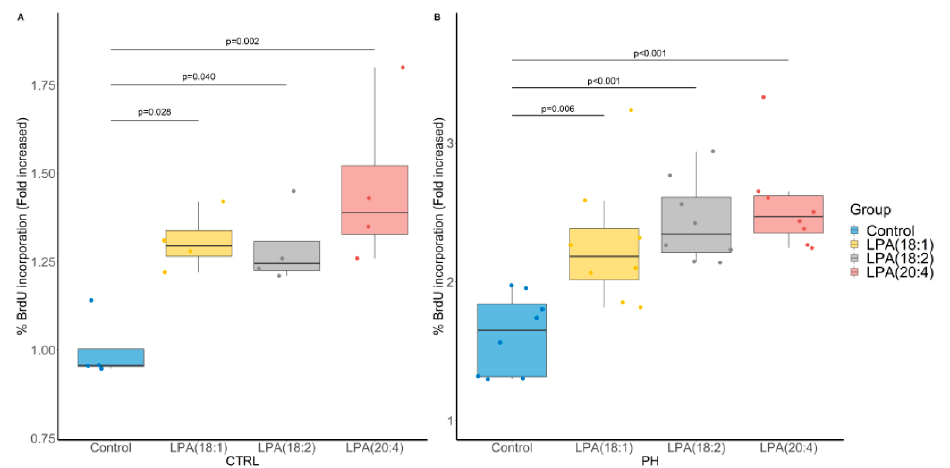
Figure 6. Impact of LPA species on cultured pulmonary artery smooth muscle cell (PA-SMC) proliferation assessed by 5-bromo-2-deoxyuridine (BrdU) incorporation. ( A ) PA-SMC derived from control (CTRL) patients (N = 4 in triplicates). ( B ) PA-SMC derived from a patient with pulmonary hypertension (PH) (8 replicates of 1 patient). p -values computed by Dunnett’s post-hoc test after ANOVA significance.